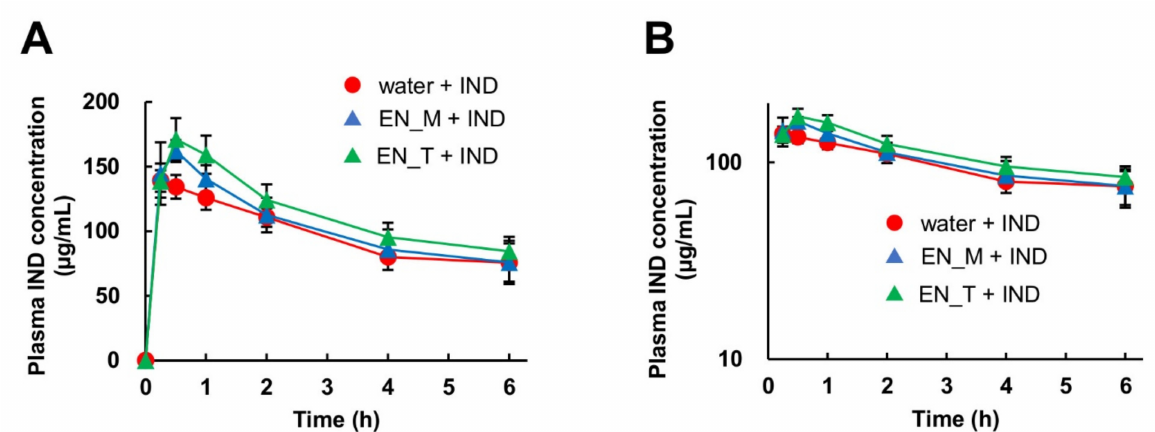
Figure 4. Effects of EN_M and EN_T on plasma IND concentrations. Blood was collected from the mice orally given 25 mL/kg of purified water, EN_M, or EN_T 30 min before subcutaneous IND (20 mg/kg) administration. LC-MS/MS was used to determine plasma IND concentrations. ( A ) Normal plot; ( B ) semilog plot. The closed red circles, blue triangles, and green triangles represent the profiles for the group treated with purified water, EN_M, and EN_T, respectively, orally 30 min before subcutaneous IND administration. Each symbol represents mean ± S.D., n = 5.